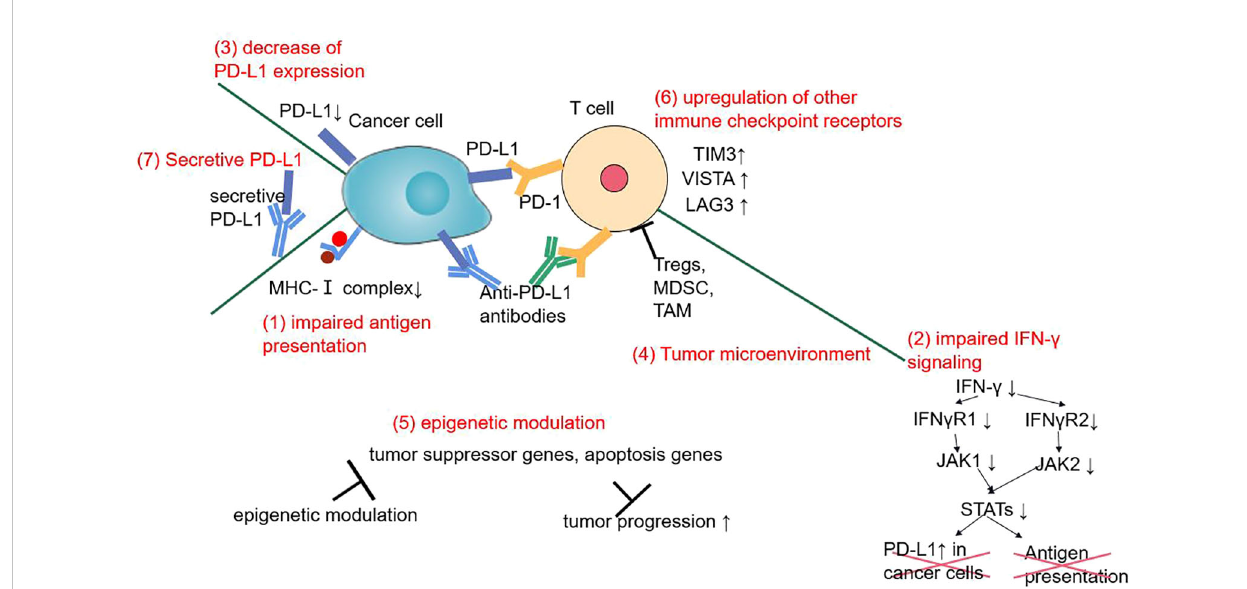
FIGURE 2 The mechanisms of primary or secondary ICI resistance in NSCLC during anti-PD-1/PD-L1